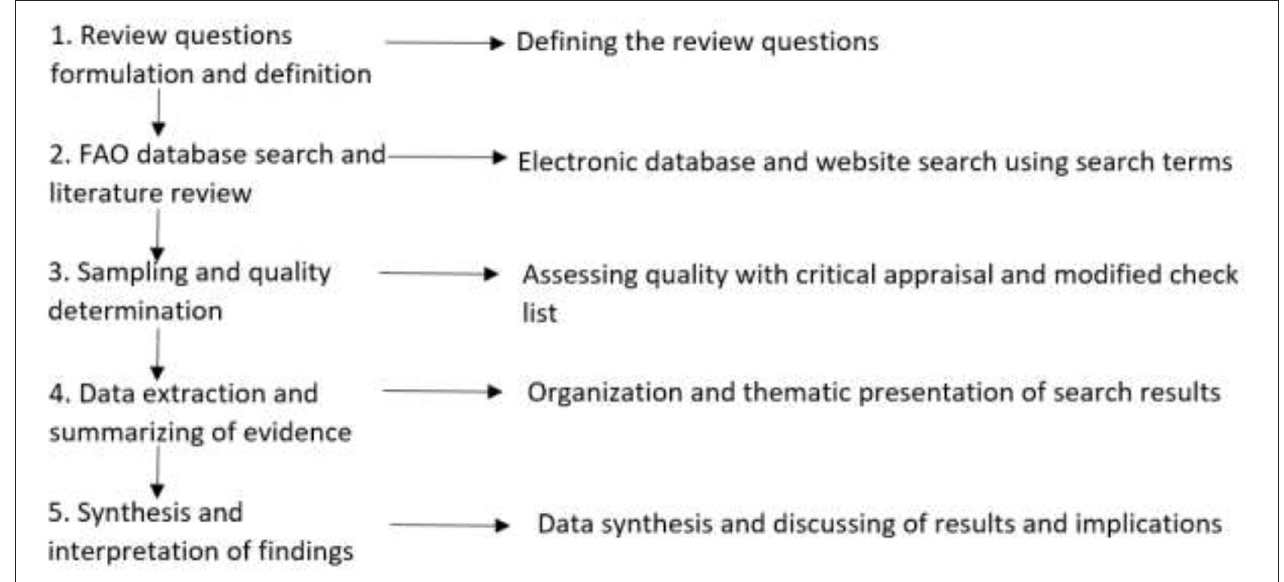
FIGURE 1 | Steps used in literature search for this review